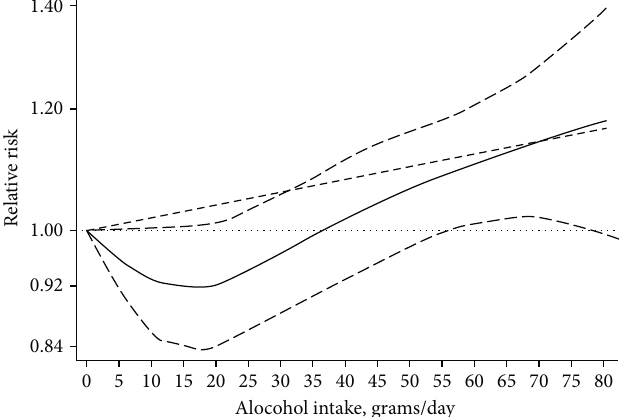
Figure 3: Dose-response relations between alcohol intake and relative risks of T2D in